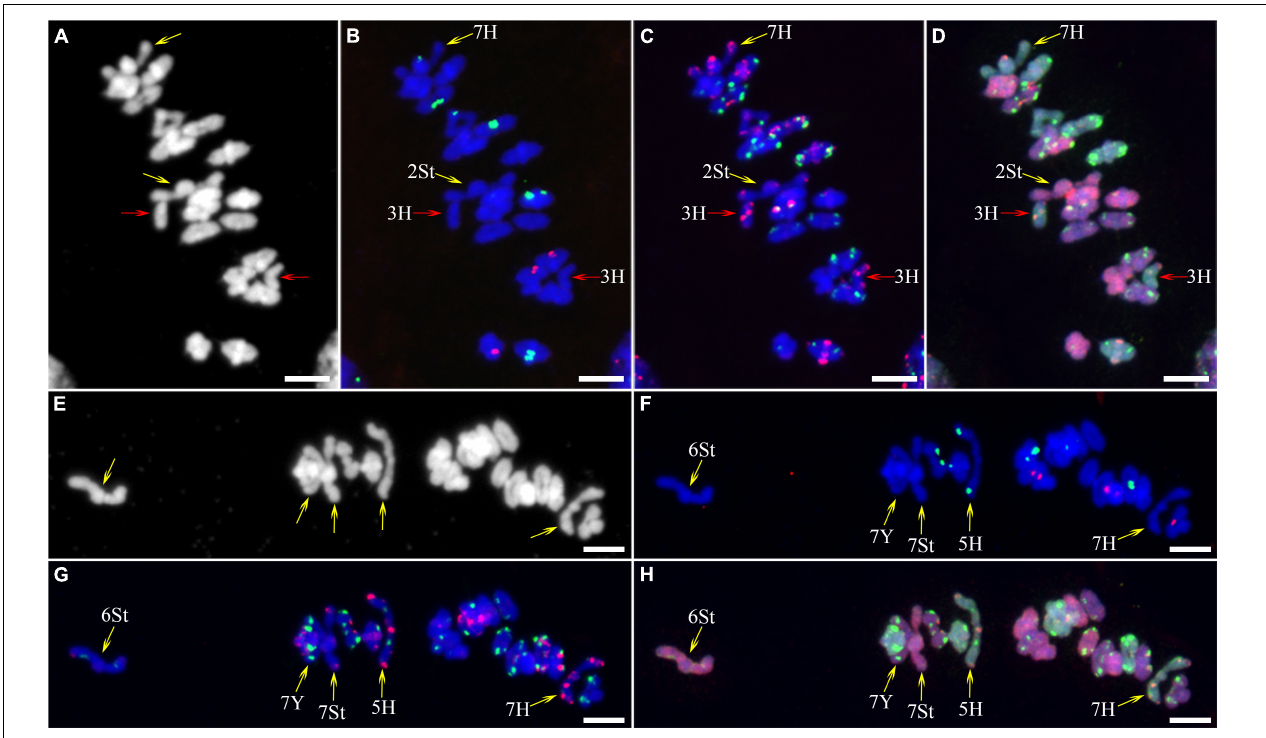
FIGURE 3 | Fluorescence in situ hybridization (FISH) patterns at meiotic metaphase I of plant A02-1 of E. nutans. (A,E) Chromosomes stained with DAPI; (B,F) pTa71-2 (red) and pSc119.2 (green); (C,G) pAs1 (red) and (AAG) 10 (green); (D,H) genomic DNA probes of P. stipifolia (red) and H. bogdanii (green). Yellow arrows: rod bivalents; red arrows: univalents. Bars = 10 µ